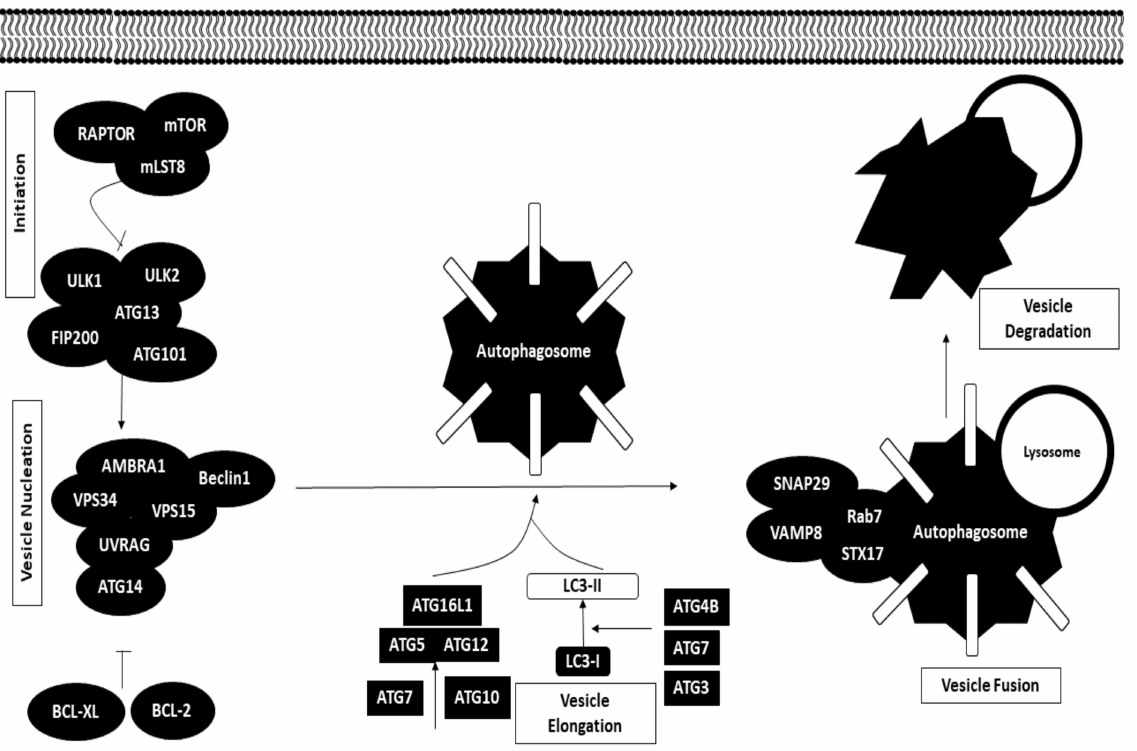
Figure 4. A brief overview of the autophagy process. RAPTOR: Regulatory-associated protein of mTOR; mTOR: Mammalian target of rapamycin; mLST8: mTOR-associated Protein, LST8 Homolog; ULK: Unc-51-like kinase; ATG: Autophagy-related gene; FIP200: FAK family kinase-interacting protein-200kD; AMBRA1: Autophagy And Beclin1 regulator 1; VPS34: phosphatidylinositol 3-kinase catalytic subunit type 3; VPS15: phosphatidylinositol 3-kinase regulatory subunit 4; UVRAG: UV radiation resistance-associated gene; BCL-xL: B cell lymphoma extra-large; BCL-2: B cell lymphoma 2; LC3: Microtubule- associated protein 1A/1B-light chain 3; SNAP29: Synaptosome-associated protein 29; VAMP8: Vesicle-associated membrane protein 8; STX17: syntaxin